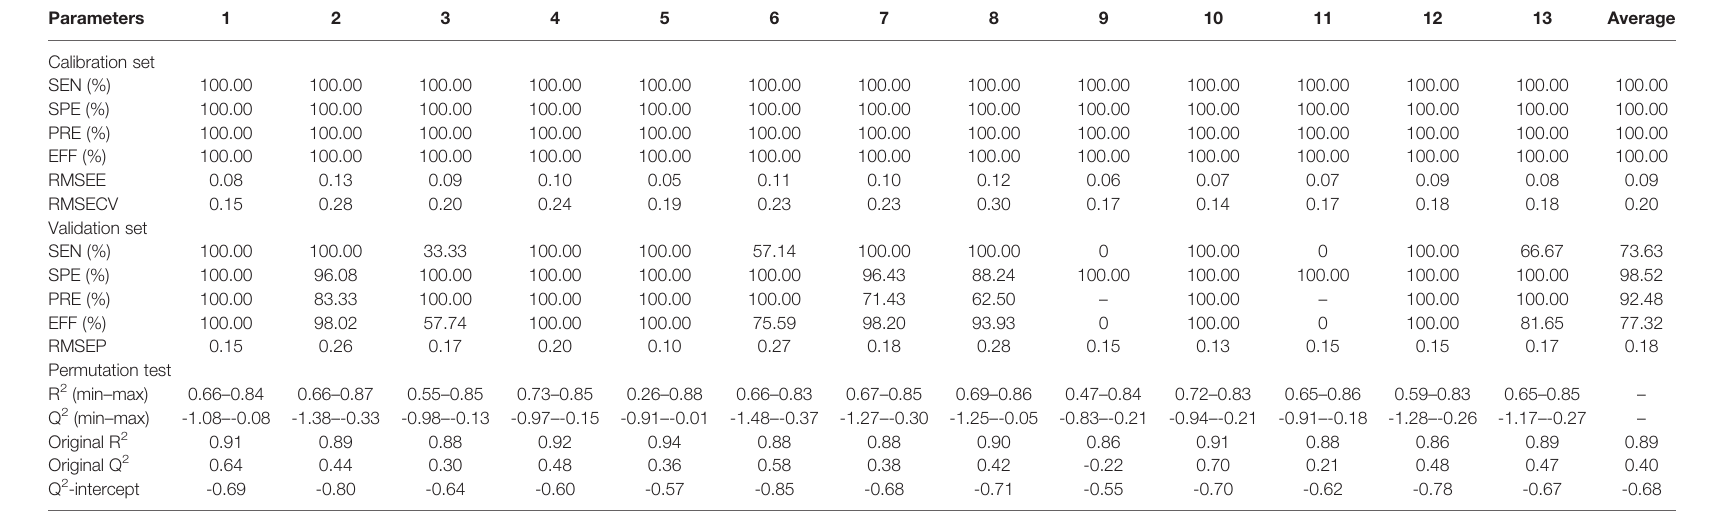
TABLE 3 | Classi fi cation parameters obtained for PLS-DA model using low-level fusion of EUL with different collection regions. Parameters Calibration set SEN (%)